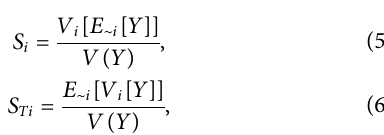
Frontiers in Big Data |